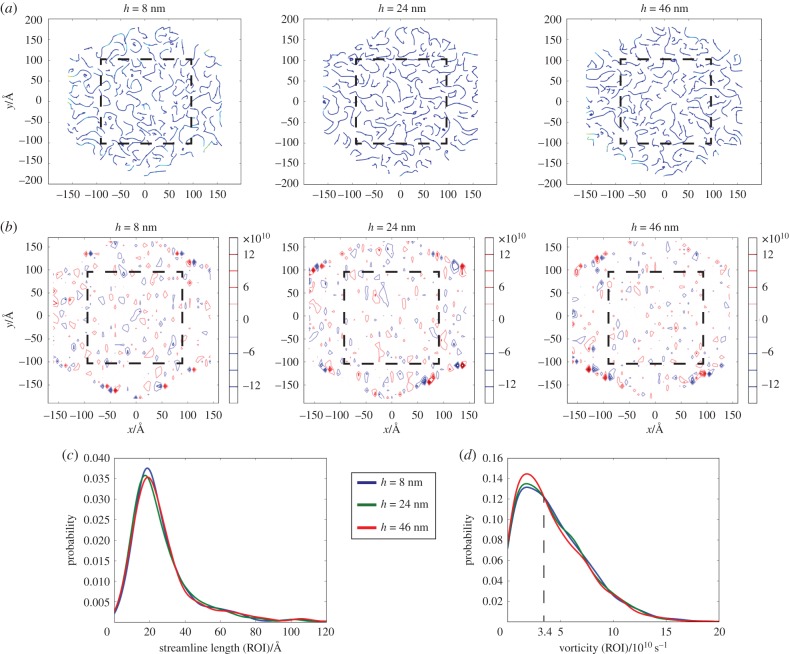
Streamline and vortex distributions of three horizontal layers extracted from three sub-regions. (a) Time-averaged snapshot, from 29 to 30 ns, of streamlines in three layers with heights of 8, 24 and 46 nm, respectively. Dash box in each panel marks the region of interest (ROI). (b) Time-averaged snapshot, from 29 to 30 ns, of vortices in three layers with heights of 8, 24 and 46 nm, respectively. Dash box in each panel marks the ROI. (c) Probability density curves of streamline length for ROIs within three layers. (d) Probability density curves of vorticity for ROIs within three layers.